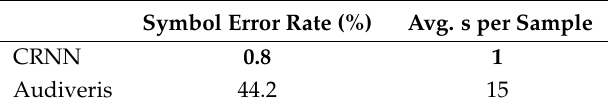
Table 6. Quantitative comparison with respect to accuracy (Symbol Error Rate in%) and processing time (avg. seconds per sample) between our CRNN-based approach and Audiveris. Values in bold highlight the best results in each